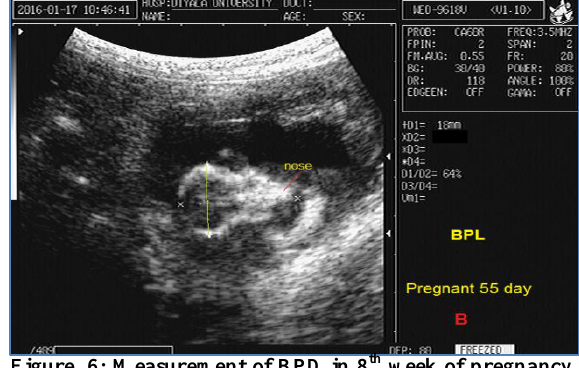
Figure, 6: Measurement of BPD in 8 th week of pregnancy, indicated by straight line (Sector probe, 3.5MHz).